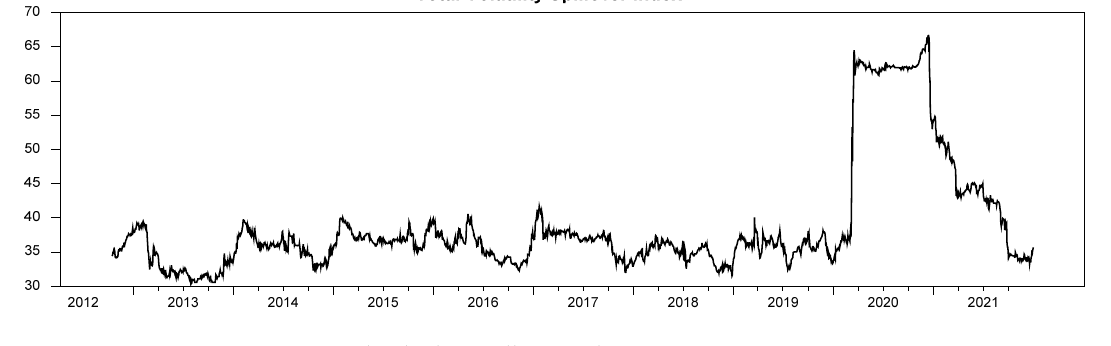
Figure 6. Total Volatility Spillover Index.